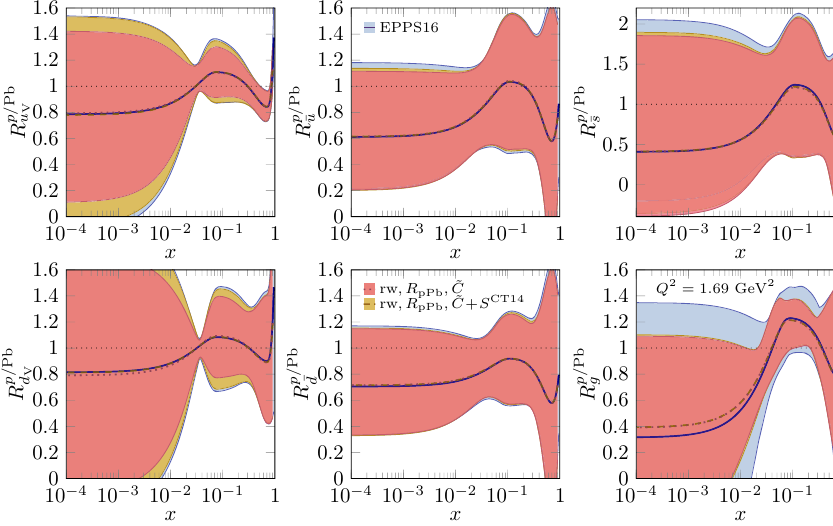
Fig. 17 As Fig. 15, but using mock data with reduced statistical